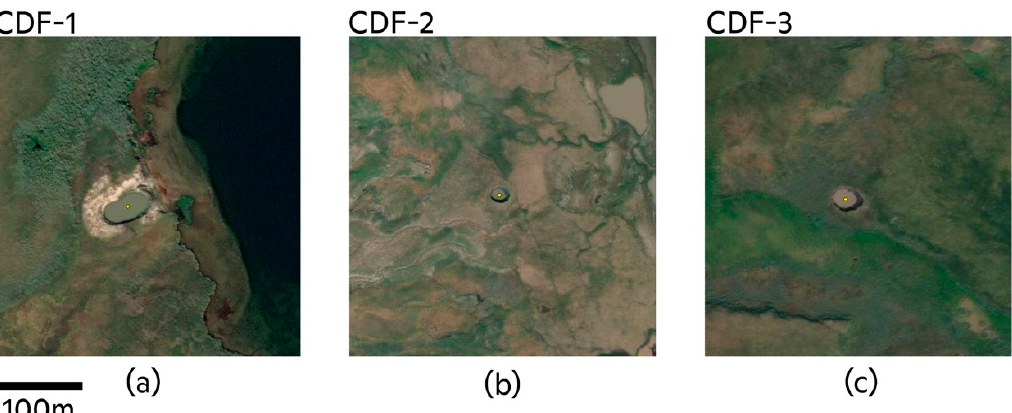
Figure 5. Three GEC-like change detection features (CDF) identified using the change detection algorithm: CDF-1 ( a ), CDF-2 ( b ), and CDF-3 ( c ). Imagery © 2020, DigitalGlobe